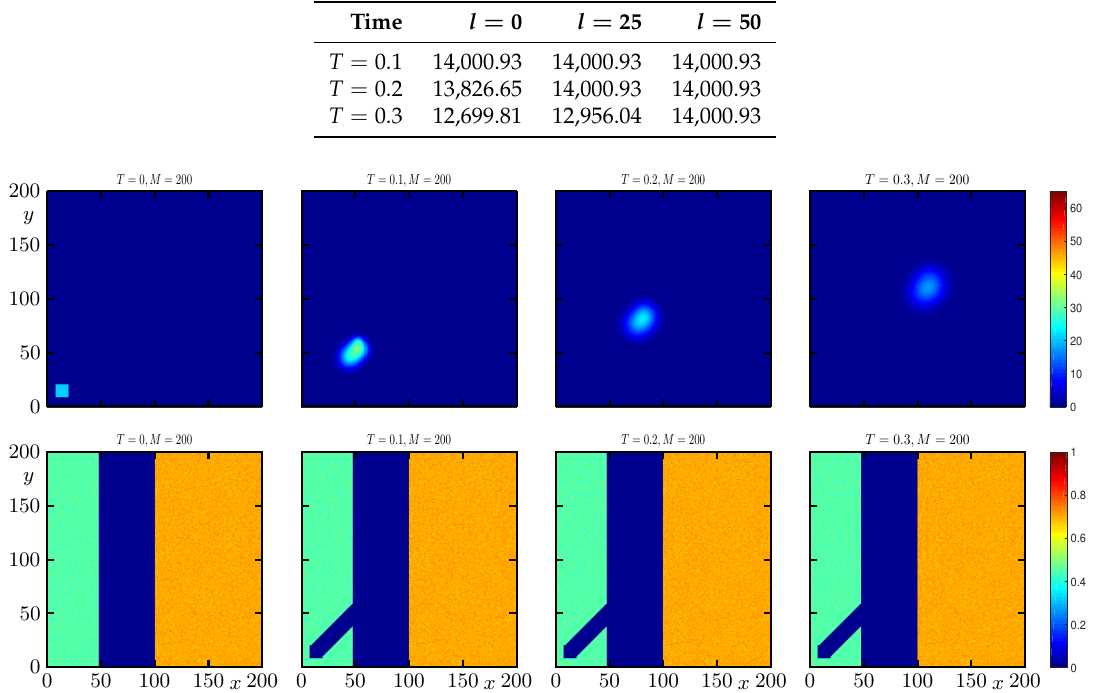
Figure 8. Example 3: Evolution of the dynamics of temperature ( top ) and fuel ( bottom ). Extinction of fire by a sufficiently wide